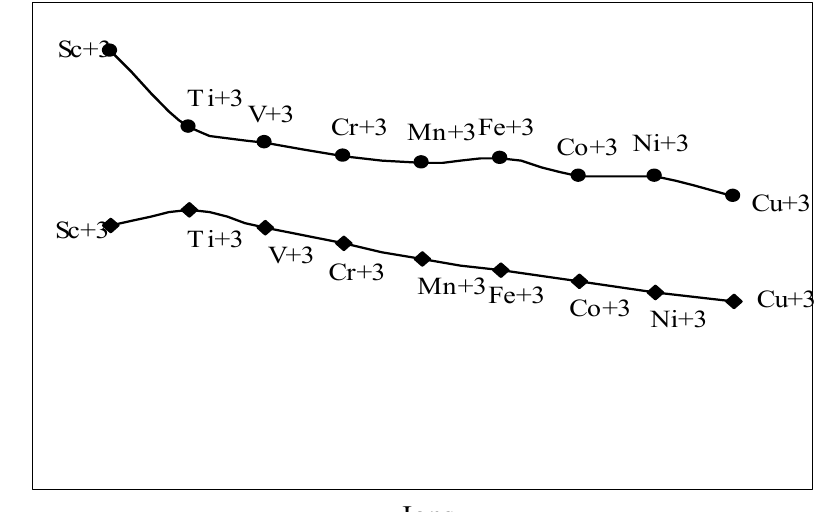
Figure 4. Plot of radii of tripositive ions of first transition series (3d-block)